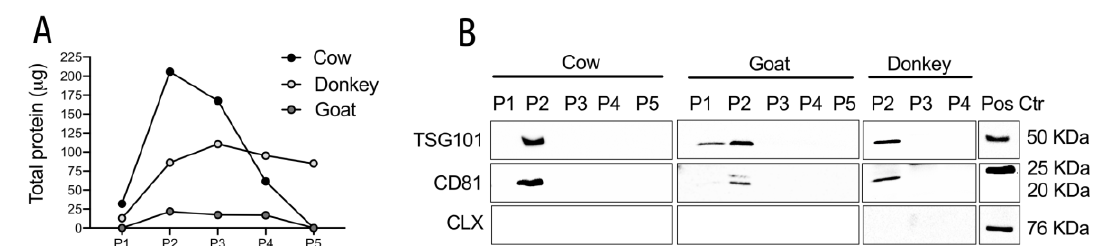
Figure 2. ( A ) Total amount of proteins in the pools of the gradient fractions from cow, goat and donkey milk. Data from representative experiments are reported. ( B ) Detection of the EV markers in the sucrose gradient pools of fractions. The indicated pools were immunoblotted with TSG101 (upper panels), CD81 (middle panels ) and calnexin (lower panels). Each sample contained 30 μg proteins except for the donkey samples that contained 10 μg. The P1 and P5 pools from donkey milk were not tested because the total protein content was not sufficient. Positive controls were: Jurkat cells for CD81 and calnexin (CLX); cow MEVs isolated in previous experiments for TSG101. For each species at least two different preparations were tested; representative images are reported in the panels.